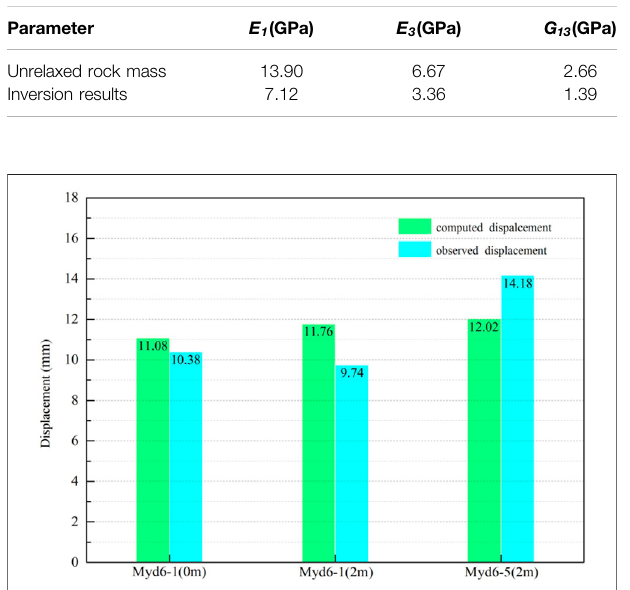
TABLE 4 | The inversion results.